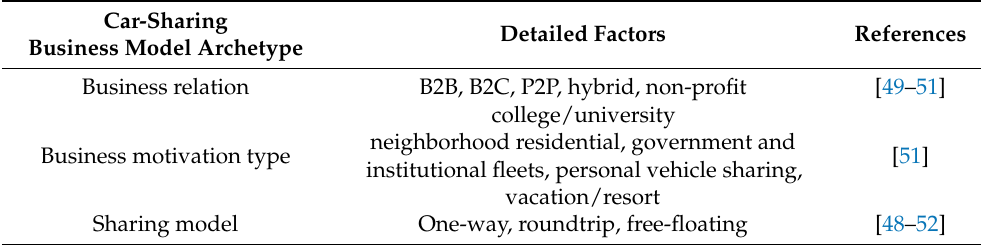
Table 1. Car-sharing business model